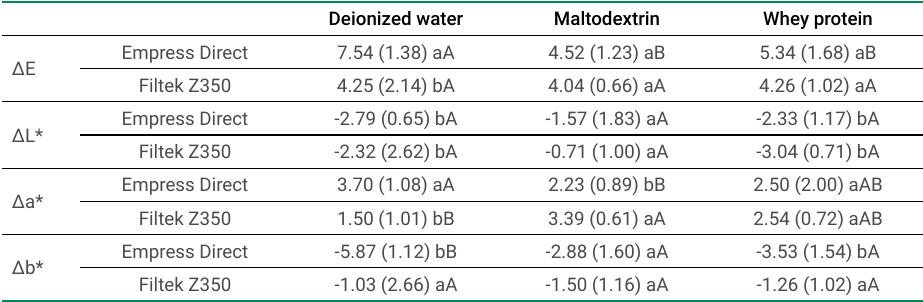
Table 3. Mean and standard deviation (SD) of ΔE, ΔL, Δa* and Δb* of resins after immersion in solutions.